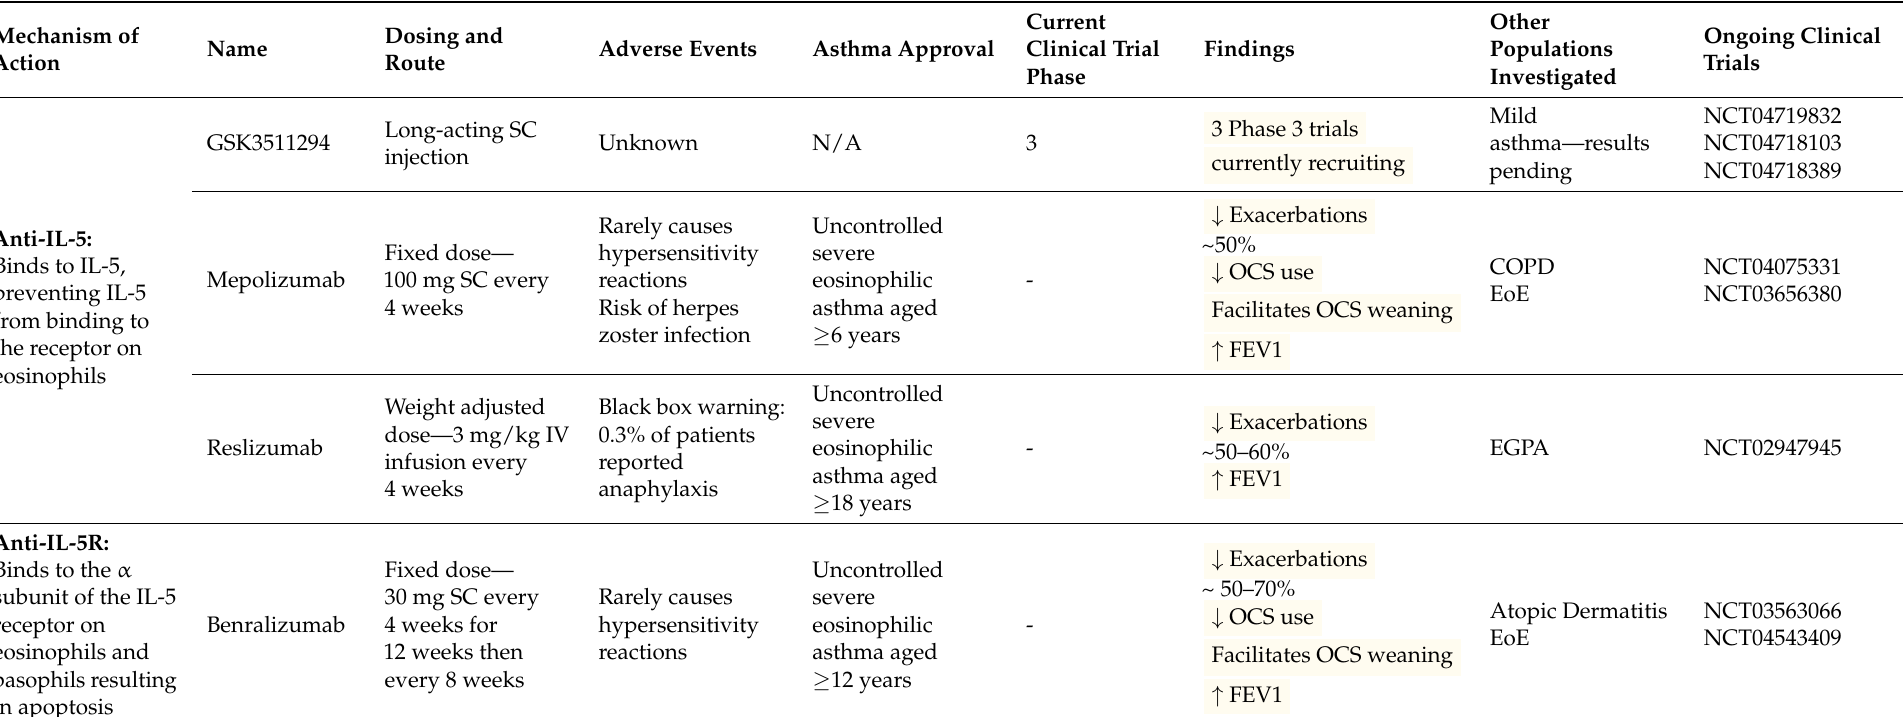
Table 1. Eosinophil-targeted